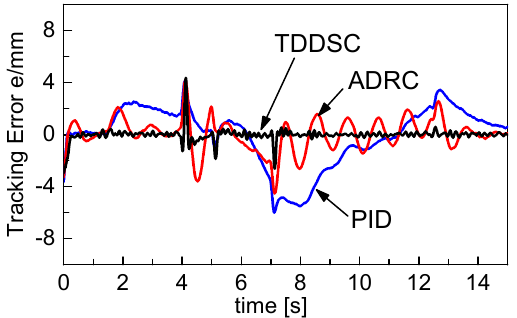
Figure 9. Tracking errors of the TDDSC, active disturbance rejection controller (ADRC), and proportional–integral–derivative (PID) algorithms as a function of time.